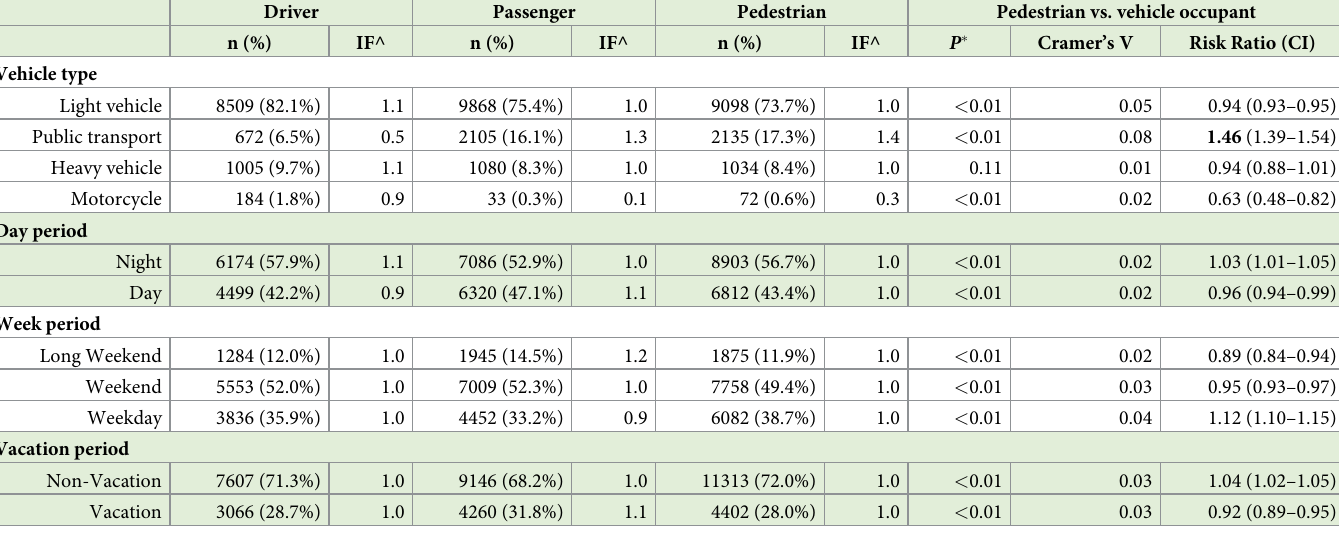
Table 1. Crash and temporal risk factors for fatal crashes by road user mode of